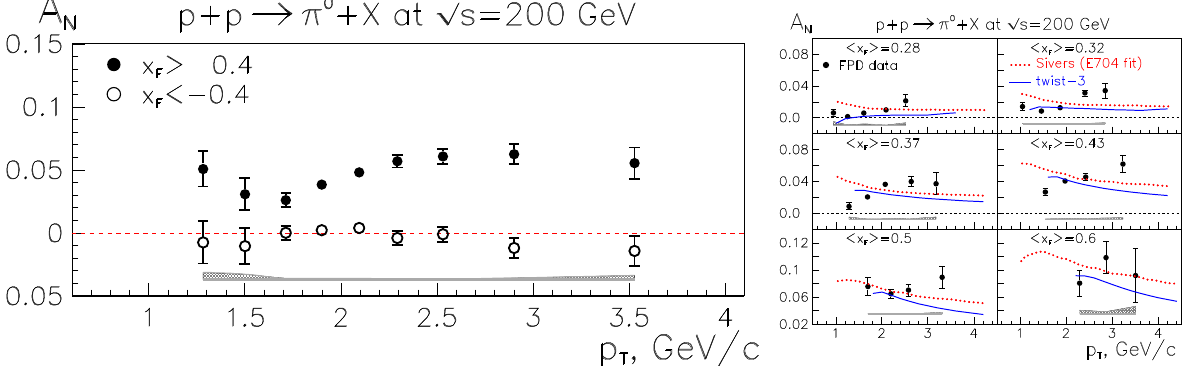
Figure 7. The p T dependence of A N for forward neutral pion production is shown. (Left) p T dependence requiring a threshold value for x F and (right) fully separated x F , p T dependencies both show a plateau of A N with increasing p T